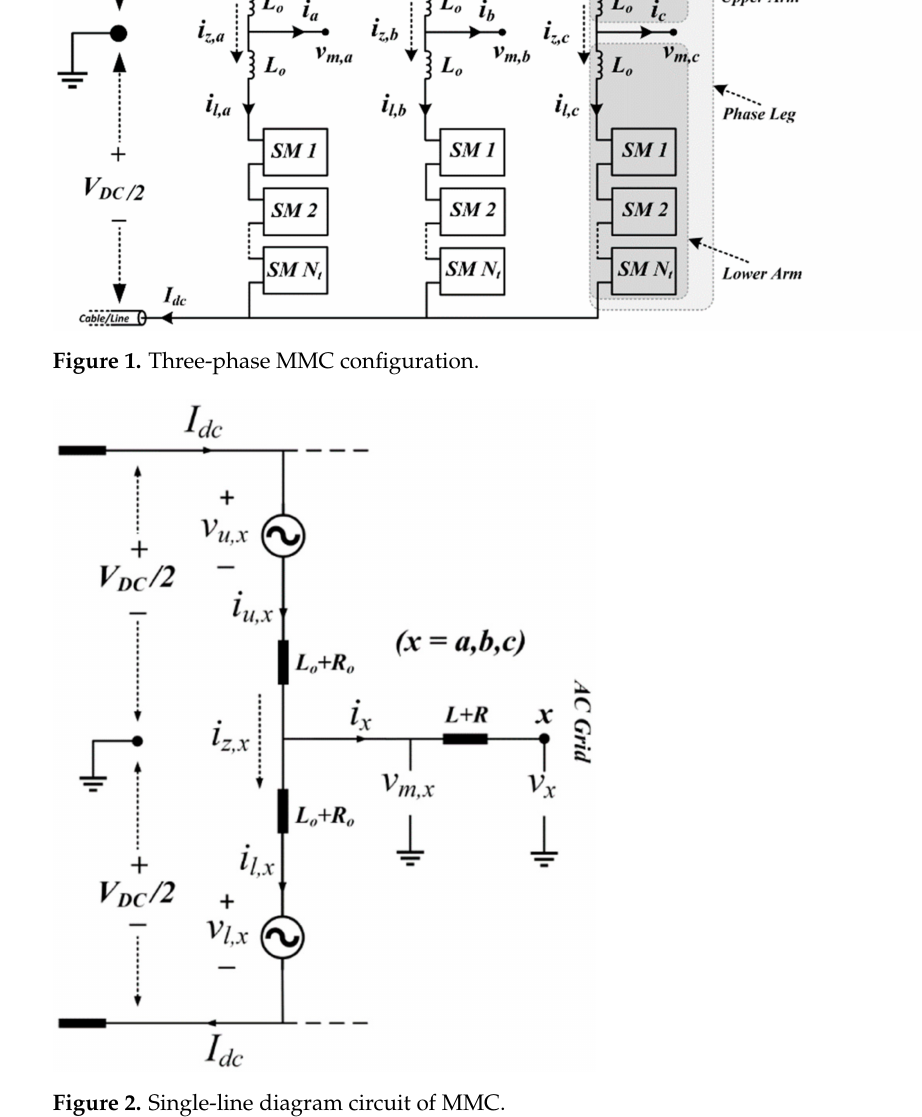
Figure 2. Single-line diagram circuit of